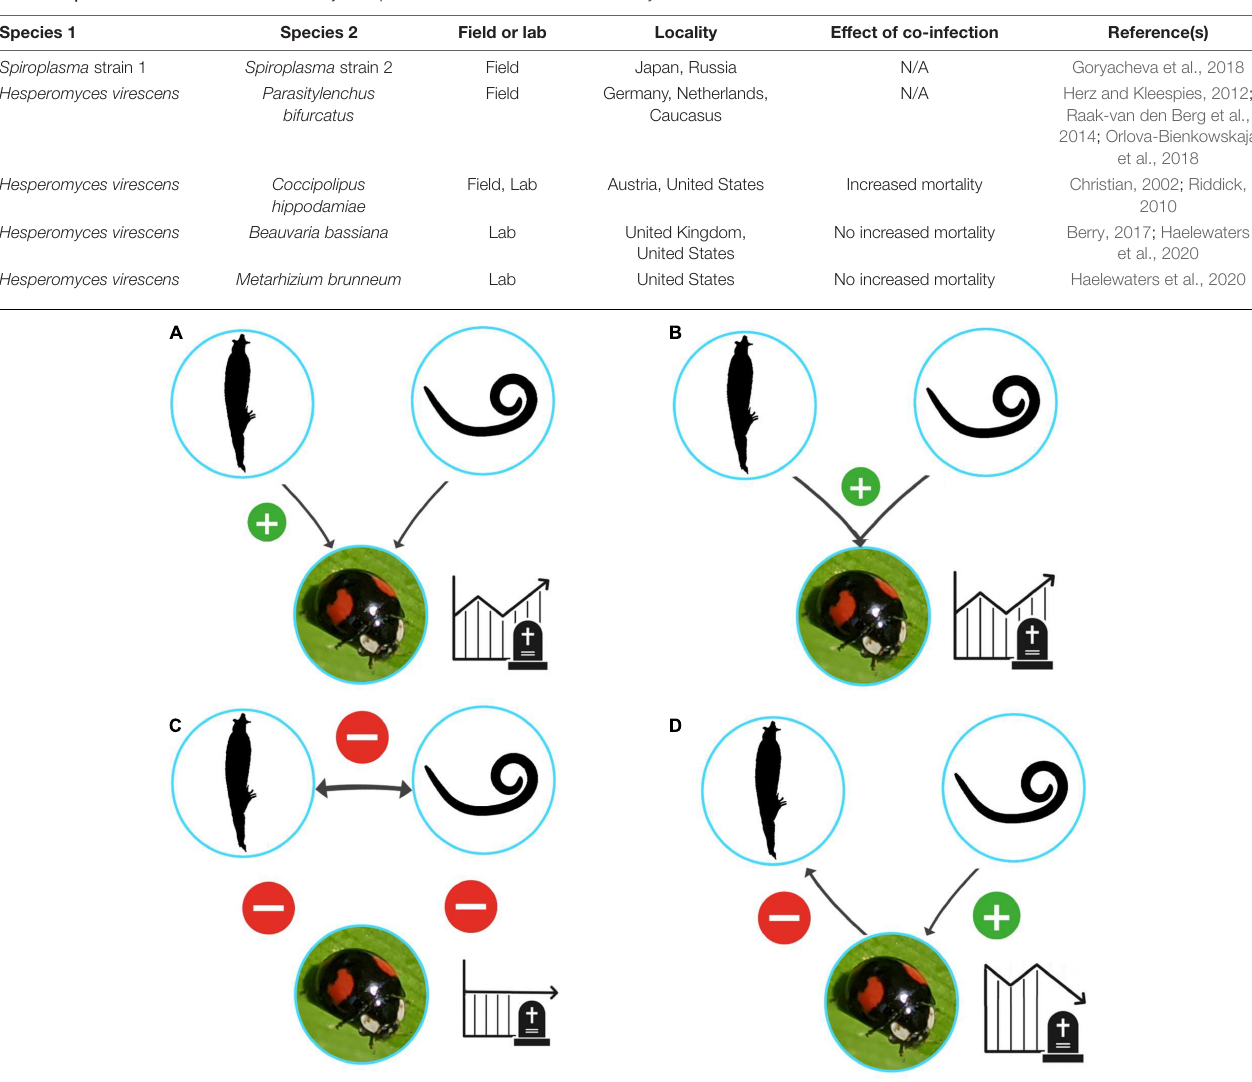
TABLE 1 | Known simultaneous infections by multiple natural enemies on Harmonia axyridis and their effect on the host.